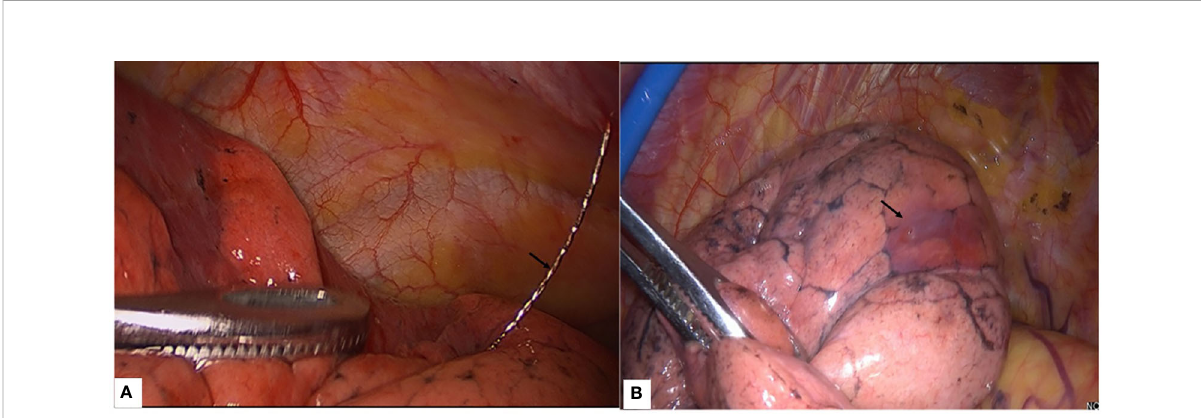
FIGURE 1 The localization of hookwire and medical glue in VATS surgery. (A) Hookwire needle (black arrow) located in the left lower lobe. (B) The medical glue (black arrow) is located in the upper lobe of the left lung, and the solid medical glue in the lung can be palpated with the fi ngers or determined by the needle puncture sites on the visceral